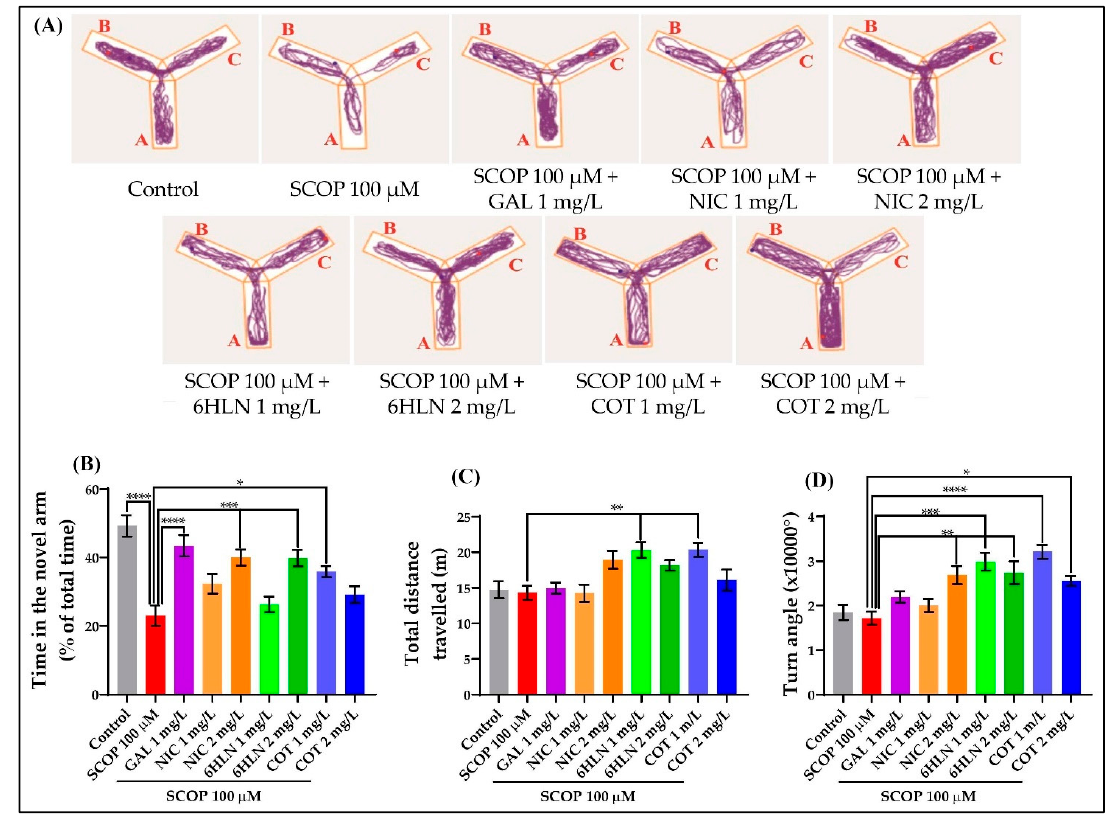
Figure 4. The effects of nicotine (NIC), 6 ‐ hydroxy ‐ L ‐ nicotine (6HLN), and cotinine (COT) (1 and 2 mg/L) administration in scopolamine (SCOP) ‐ treated zebrafish on spatial memory and locomotor activity evaluated within the Y ‐ maze task. ( A ) The representative locomotion tracking pattern of the zebrafish in the second stage of the Y ‐ maze task according to the experimental groups they belong to. The arms of the maze were denoted with A (start arm), B (other arm), and C (novel arm). The blue dot represents the beginning of the route, while the red dot represents the end of the route. The time in the novel arm ( B ) represents a parameter for spatial memory, whereas the ( C ) total distance travelled and the ( D ) turn angle is measures of locomotor activity. The values are expressed as means ± S.E.M. ( n = 10). ANOVA analysis identified overall significant differences between the experimental groups for ( B ) F(8,81) = 10.54, p < 0.0001, ( C ) F(8,81) = 5.342, p < 0.0001 and ( D ) F(8,81) = 8.96, p < 0.0001. For Tukey posthoc analyses—**** p < 0.0001, *** p < 0.001, ** p < 0.01and * p < 0.05.